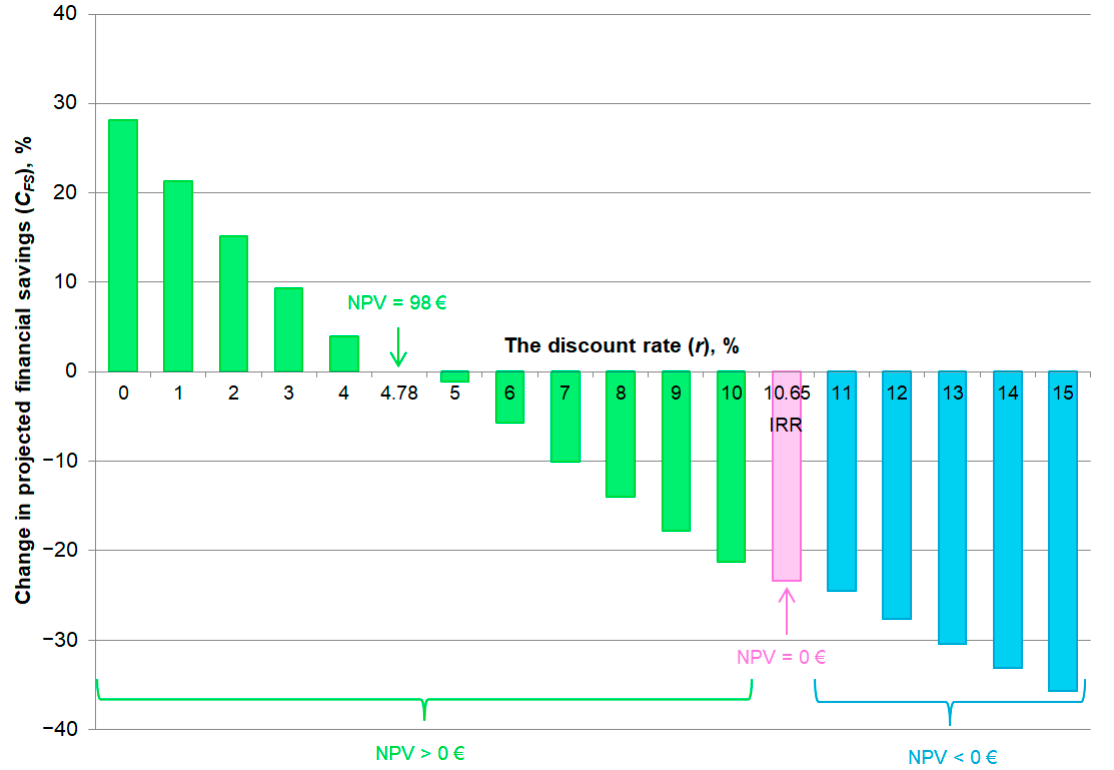
Figure 13. Impact of the discount rate on projected financial savings.